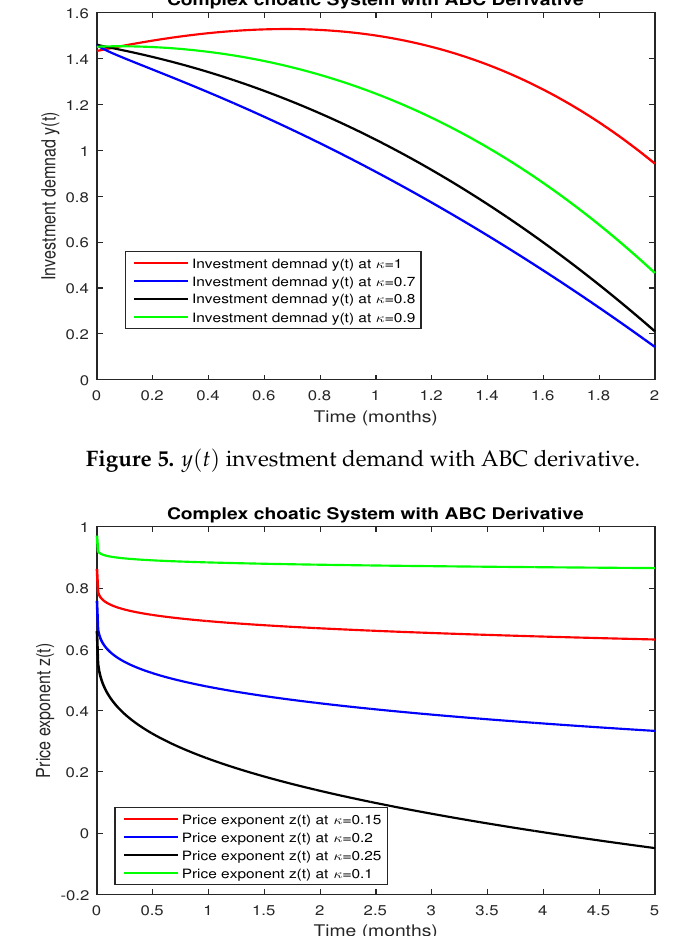
Figure 6. z ( t ) price exponent with ABC